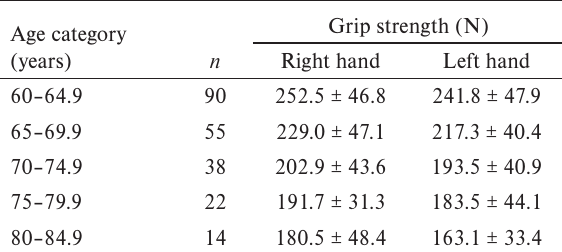
The muscle strength (mean ± SD) in age categories